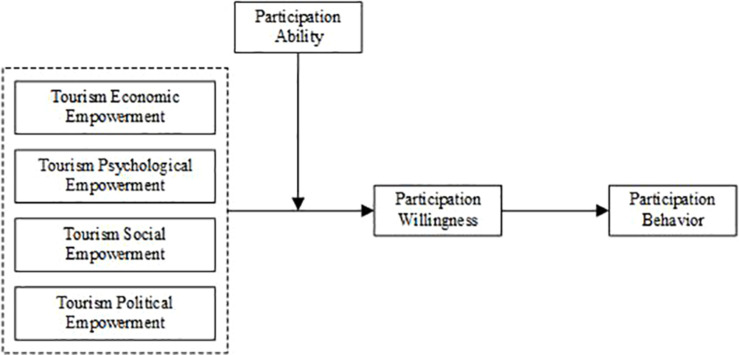
Theoretical model.